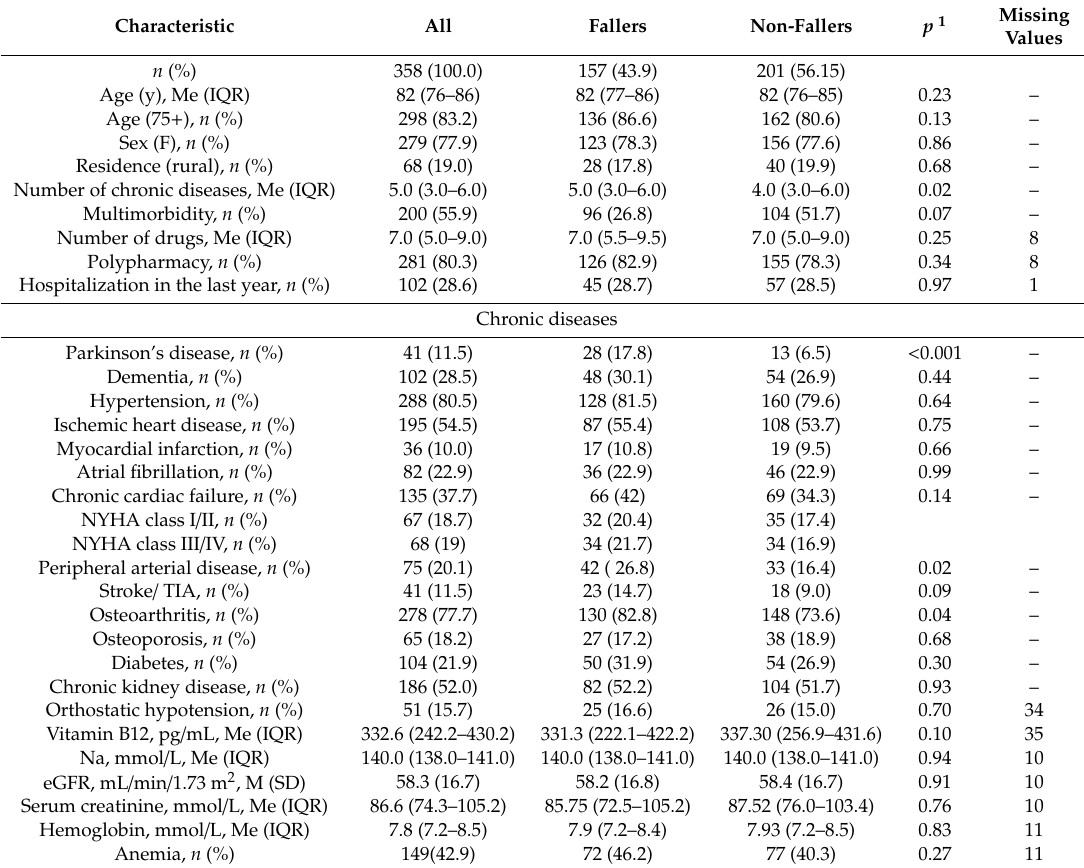
Table 1. Characteristics of study participants—sociodemographic and health correlates of falls. Characteristic All